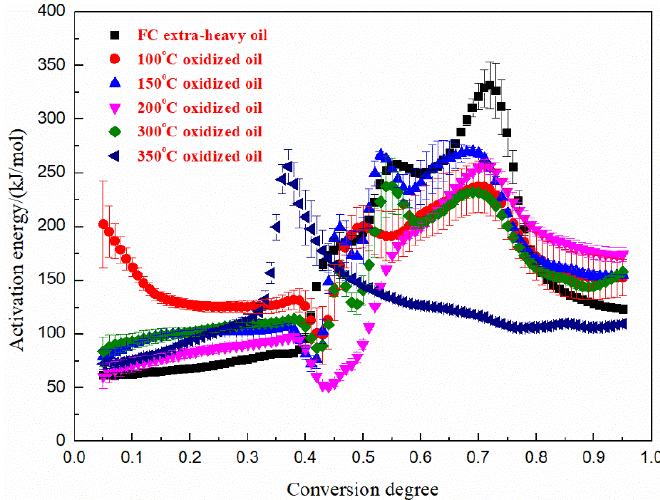
Figure 10. Relationship between the activation energy and conversion degree obtained by the Friedman model of FC extra-heavy oil and oxidized oils.